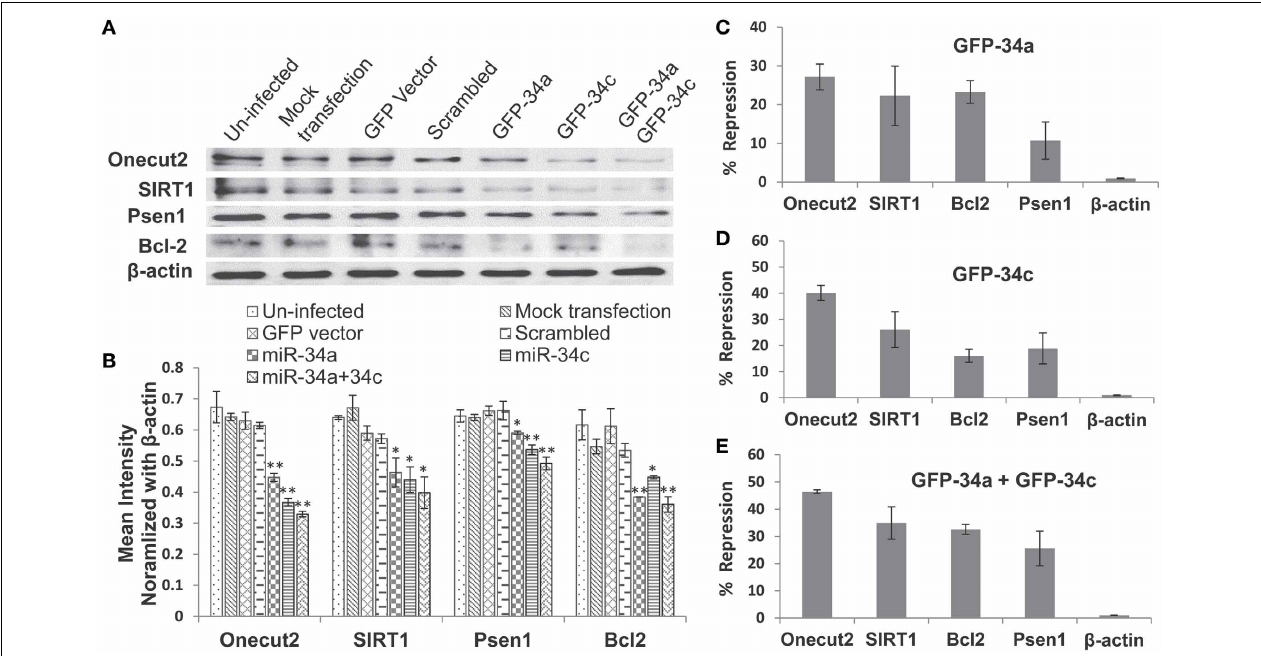
β -actin proteins; (B) Graphic representation of a comparison of band intensities between the various treatments; image intensities of Western blotted bands were normalized against the β -actin band, which is constant throughout. Graphic representation showing percent of repression, estimated using scrambled controls for comparison (panels C–E ): transfection with miR-34a (C) ; miR-34c (D) ; miR-34a and miR-34c (E) . One-way ANOVA followed by LSD test was used to determine statistical significance; ∗ P < 0 . 05, ∗∗ P < 0 . 01.